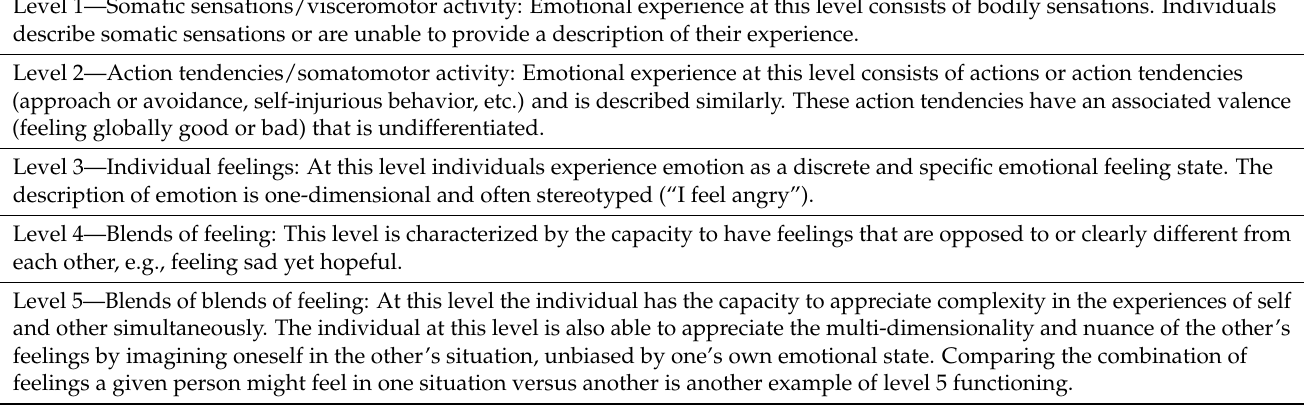
Table 1. Levels of Emotional Awareness.